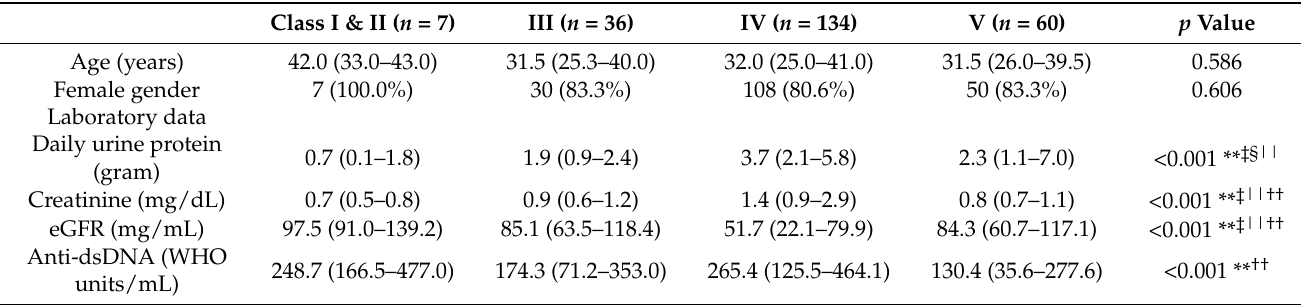
Table 1. Basic demographic data of 237 lupus nephritis patients by histological classes.